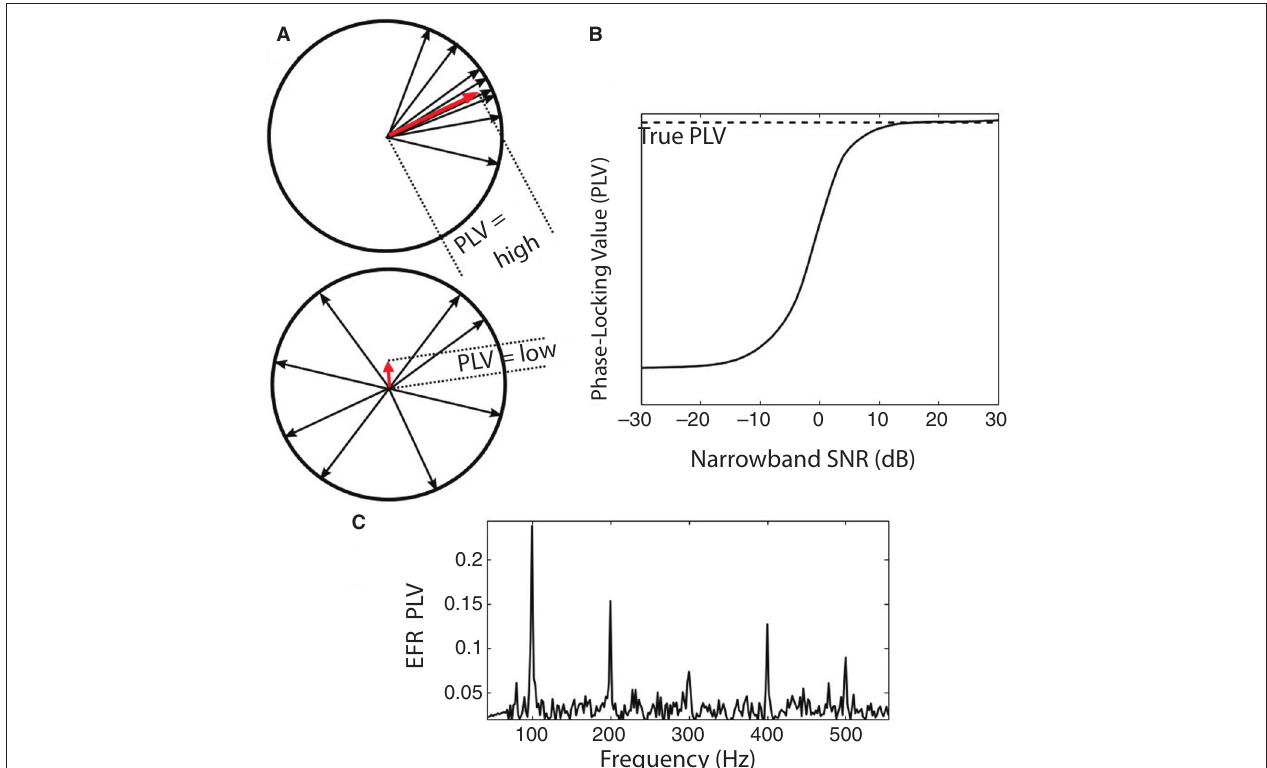
the estimated PLV for a simulated signal in additive noise. At sufficiently high SNR values, the estimated PLV converges to the true PLV (aside from a small sample bias that depends on the number of trials). At lower SNRs, the estimate is biased to be lower than the true value. This is an important consideration when comparing PLVs across sound levels or individuals, since the SNR depends on the magnitude of the true underlying response, the geometry of the generators, and the volume conductor in between. (C) Sample PLV spectrum obtained in response to a 100 Hz transposed tone at a carrier frequency of 4 kHz at 65 dB SPL (RMS). Strong peaks are evident in the PLV at multiples of the envelope